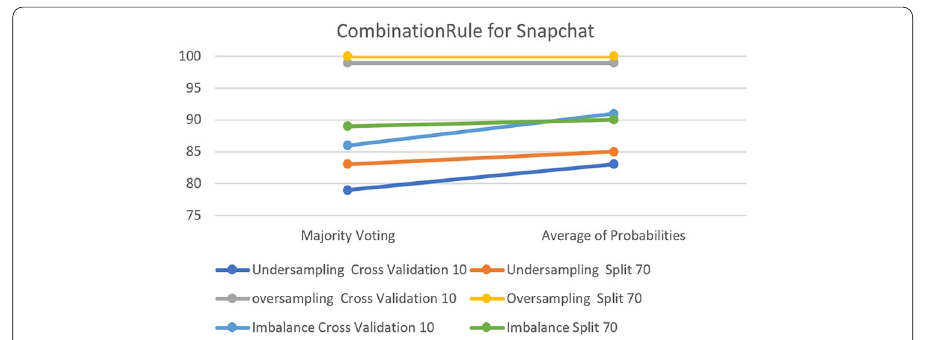
Fig. 23 The accuracy of CombinationRule for the Voting Classifier in Snapchat